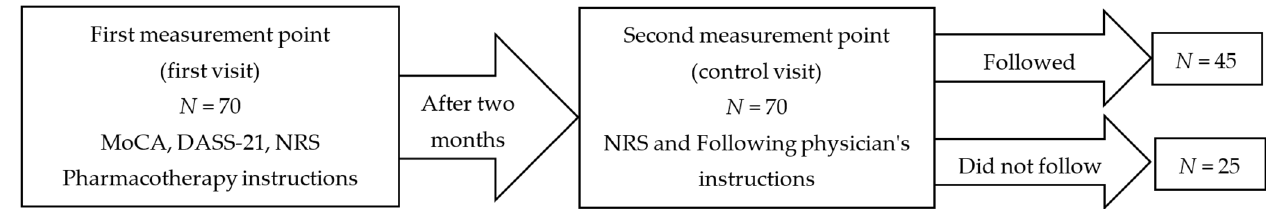
Figure 1. Study design.